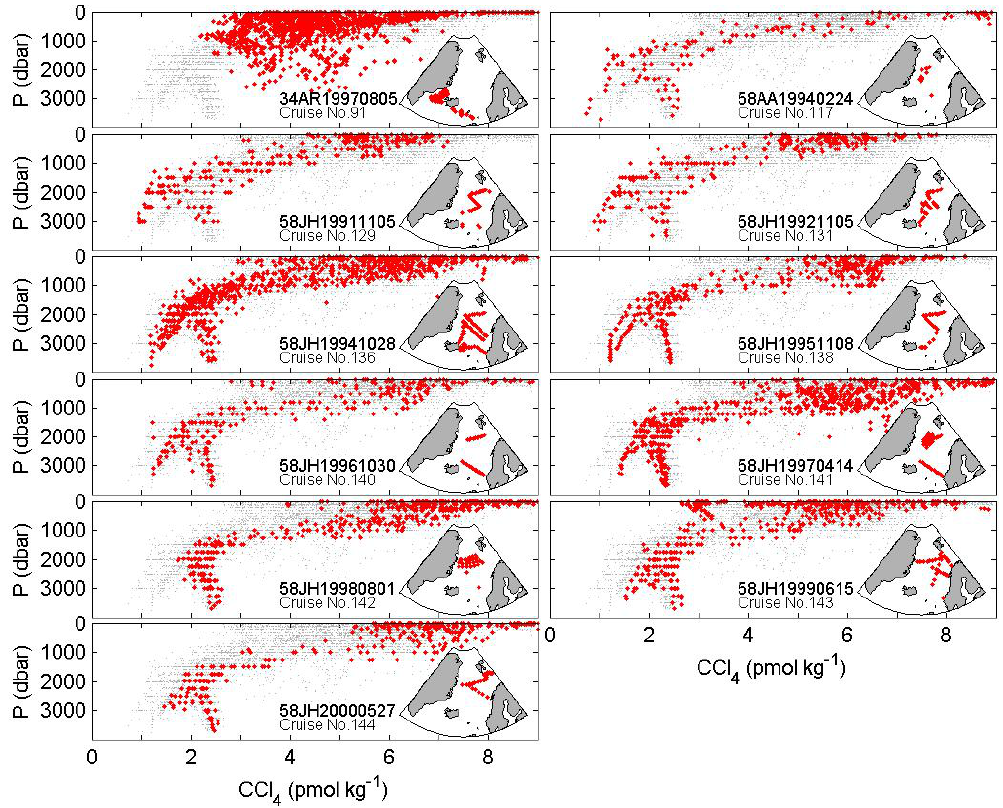
Figure 5. CCl 4 vs. pressure (dbar). See Fig. 2 for